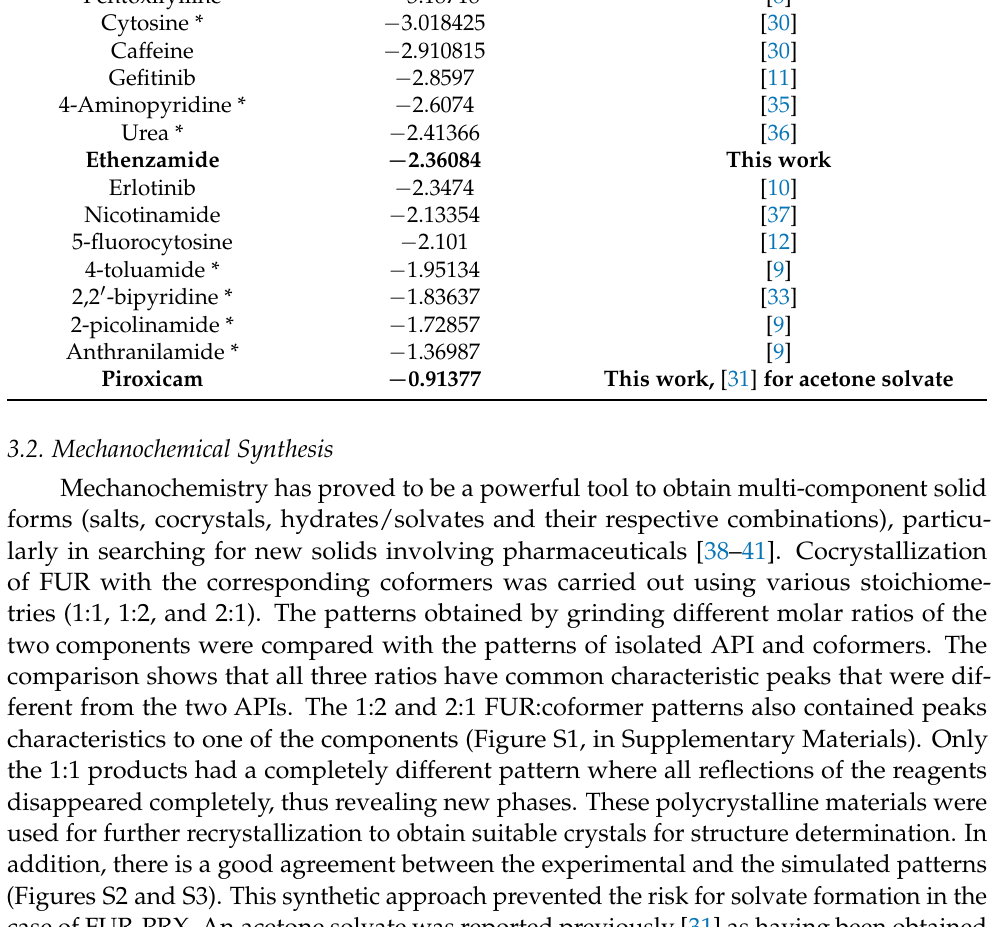
Table 2. Ranking positions for FUR coformers reported at CSD, including the two drugs used in this study (in bold) based on COSMOQuick calculations. Non-drug molecules marked with *. Coformer H ex (kcal/mol) 1,10-phenanthroline * −